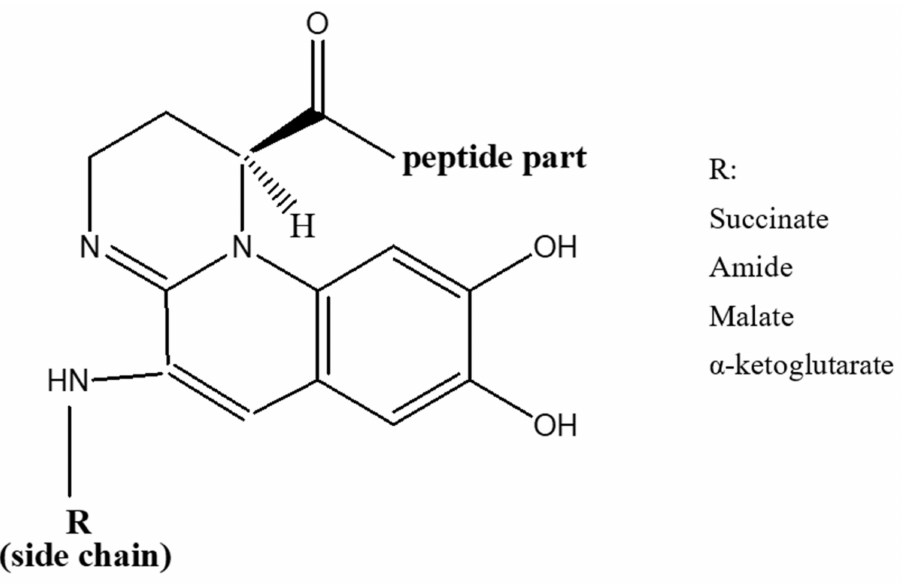
Figure 1. General structure of